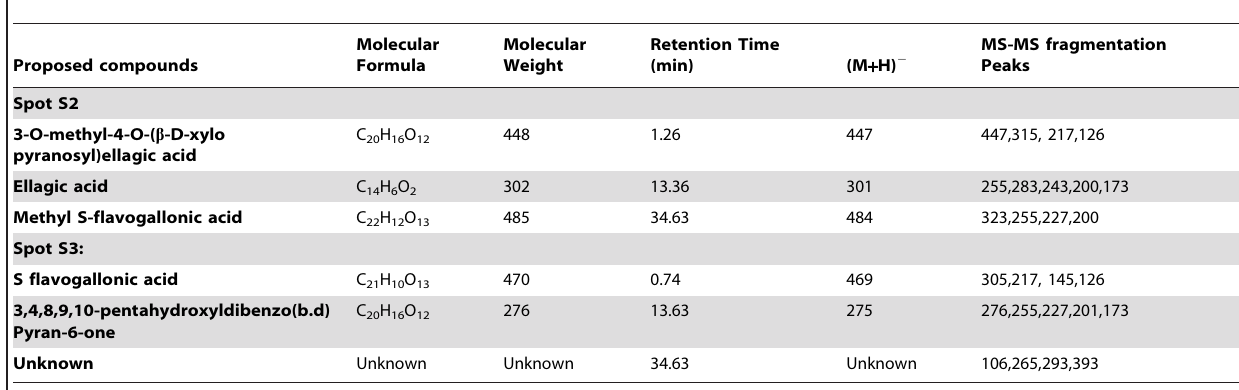
Table 2. Putative anti QS compounds as shown by LC-ESI-MS fragmentation data for the bioactive fraction.